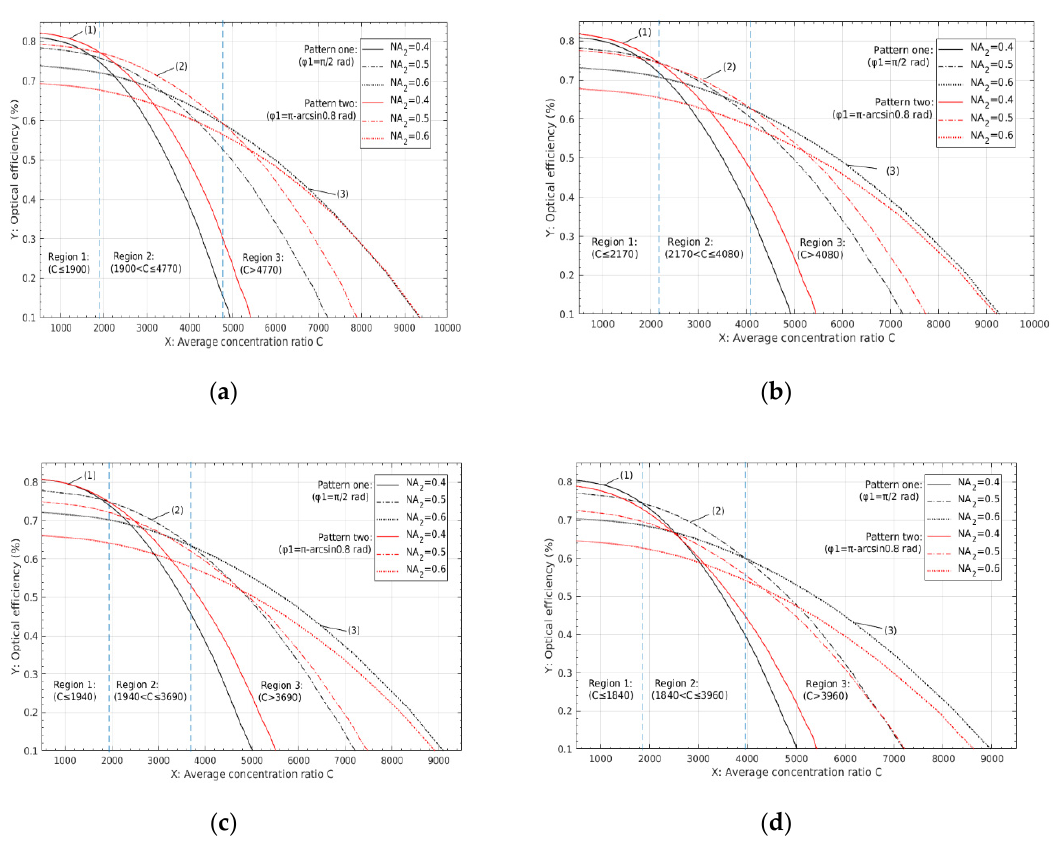
Figure 10. Results of optimal efficiency ( η opm ) vs variable of average concentration ratio ( C ) with respect to optimal patterns: ϕ 1 = π − arcsin 0.8 rad and π / 2 rad, when 0.4 ≤ NA 2 ≤ 0.6. ( a – d ) show four cases of different inclination angles ( θ inc ) respective to 0.05, 0.1, 0.15, 0.2 rads. In each figure, ( 1 ), ( 2 ), ( 3 ) represent the best solutions for region 1, region 2, region 3, respectively.